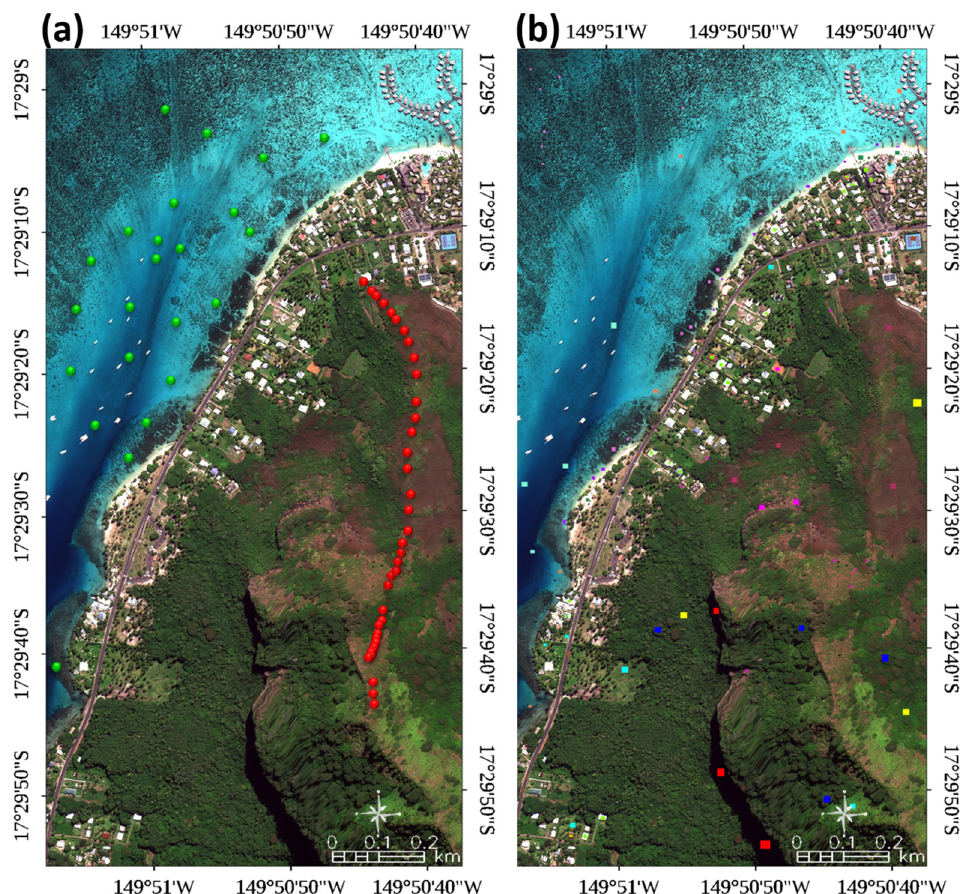
Figure 1. Natural-coloured WorldView-3 imagery (0.3 m × 0.3 m, 3017 × 5937 pixels) of the study area on Moorea Island (French Polynesia). ( a ) The red and green spheres represent 32 topographic and 35 bathymetric calibration/validation datasets; ( b ) the array of 105 multi-colour rectangles represents 78,000 pixels of 13 habitats, each one composed by 3000 calibration and 3000 validation pix- els.